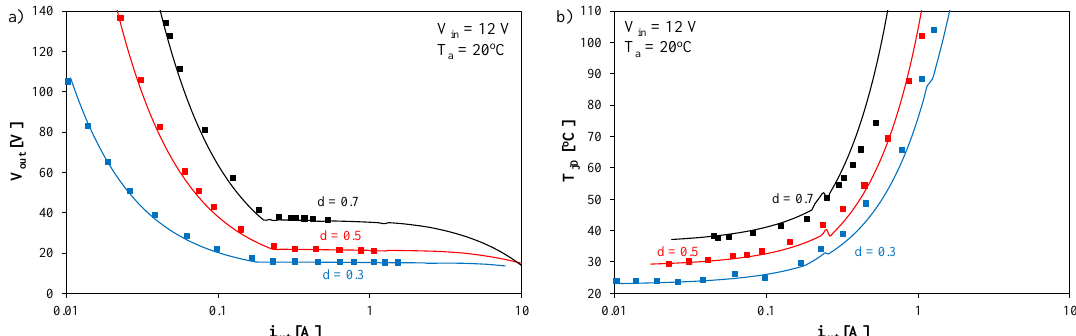
Figure 16. Computed and measured output characteristics of the tested DC–DC converter ( a ) and dependences of internal temperature of the diode on converter output current ( b ) for selected values of duty cycle.